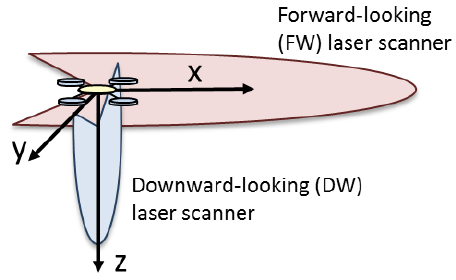
Figure 2. Installation orientations of the two 2D laser scanners.